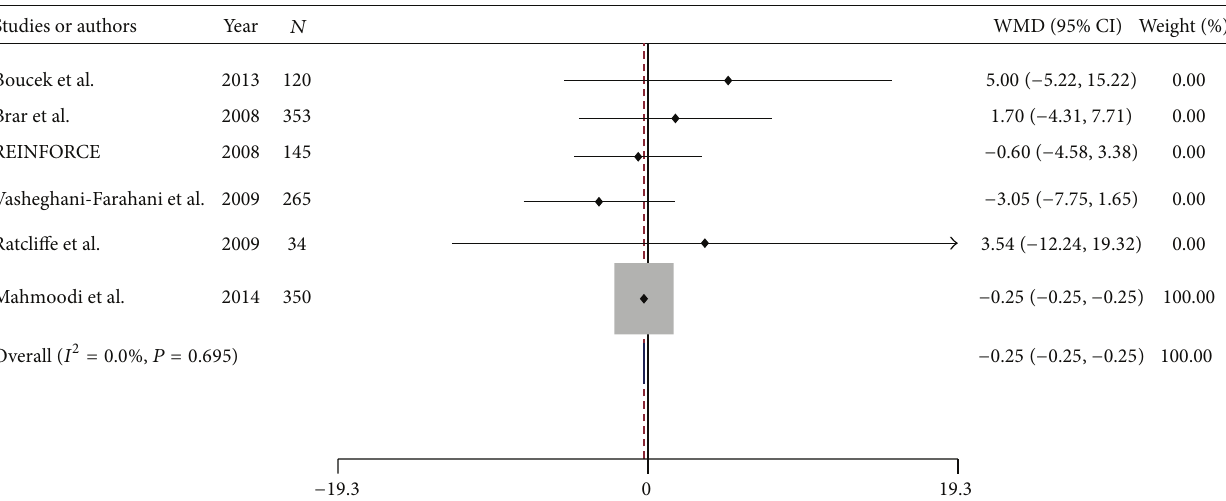
alone had trend towards reducing the incidence of CIN with an OR of 1.32 (95% CI: 0.87–1.99; 𝑃 = 0.1 ) using a random model. Significant heterogeneity was observed among the RCTs (chi-squared = 8.42, 𝐼 2 = 52.5 %) (Figure